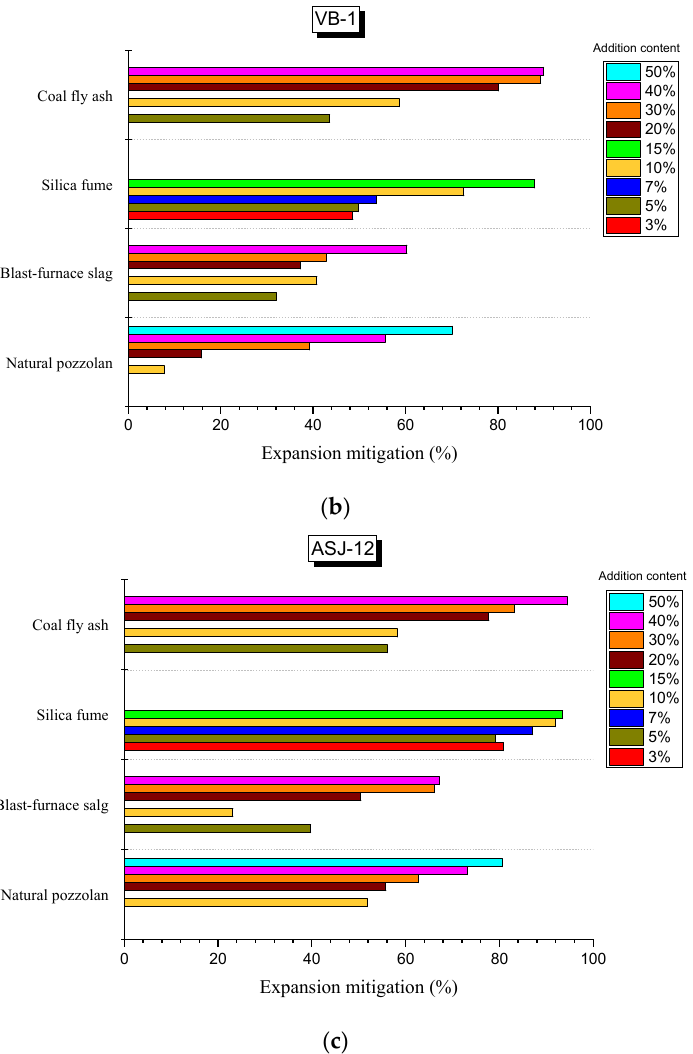
Figure 9. Alkali-silica mitigation by four pozzolanic additions in percentages from 3% to 50% in mortars made with three aggregates: ( a ) non-reactive siliceous sand, ASJ_2; ( b ) siliceous gravel with moderate reactivity, VB; ( c ) reactive siliceous pebble, ASJ_12.